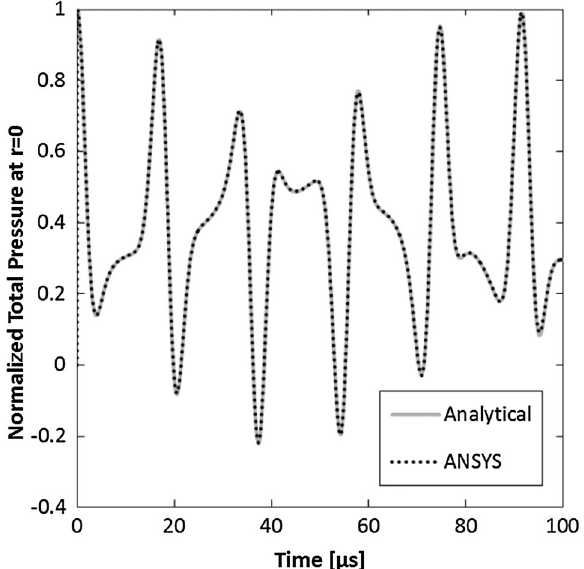
FIG. 6. Normalized total pressure at r ¼ R for the test case assuming plane stress.